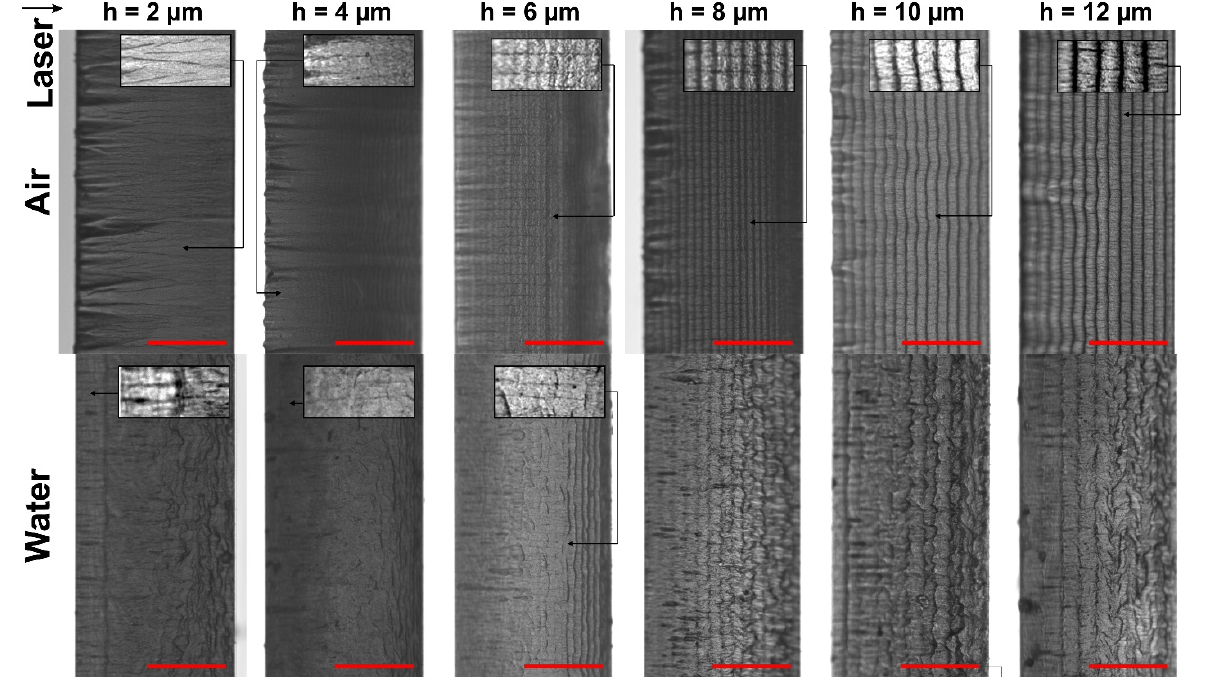
Figure 7. Optical micrographs of cut sidewalls. Cases for cutting in ambient air and water at different hatch values are presented. Scale bars represent 0.2 mm and apply to all panels in this figure. The laser beam entry side is indicated with an arrow.